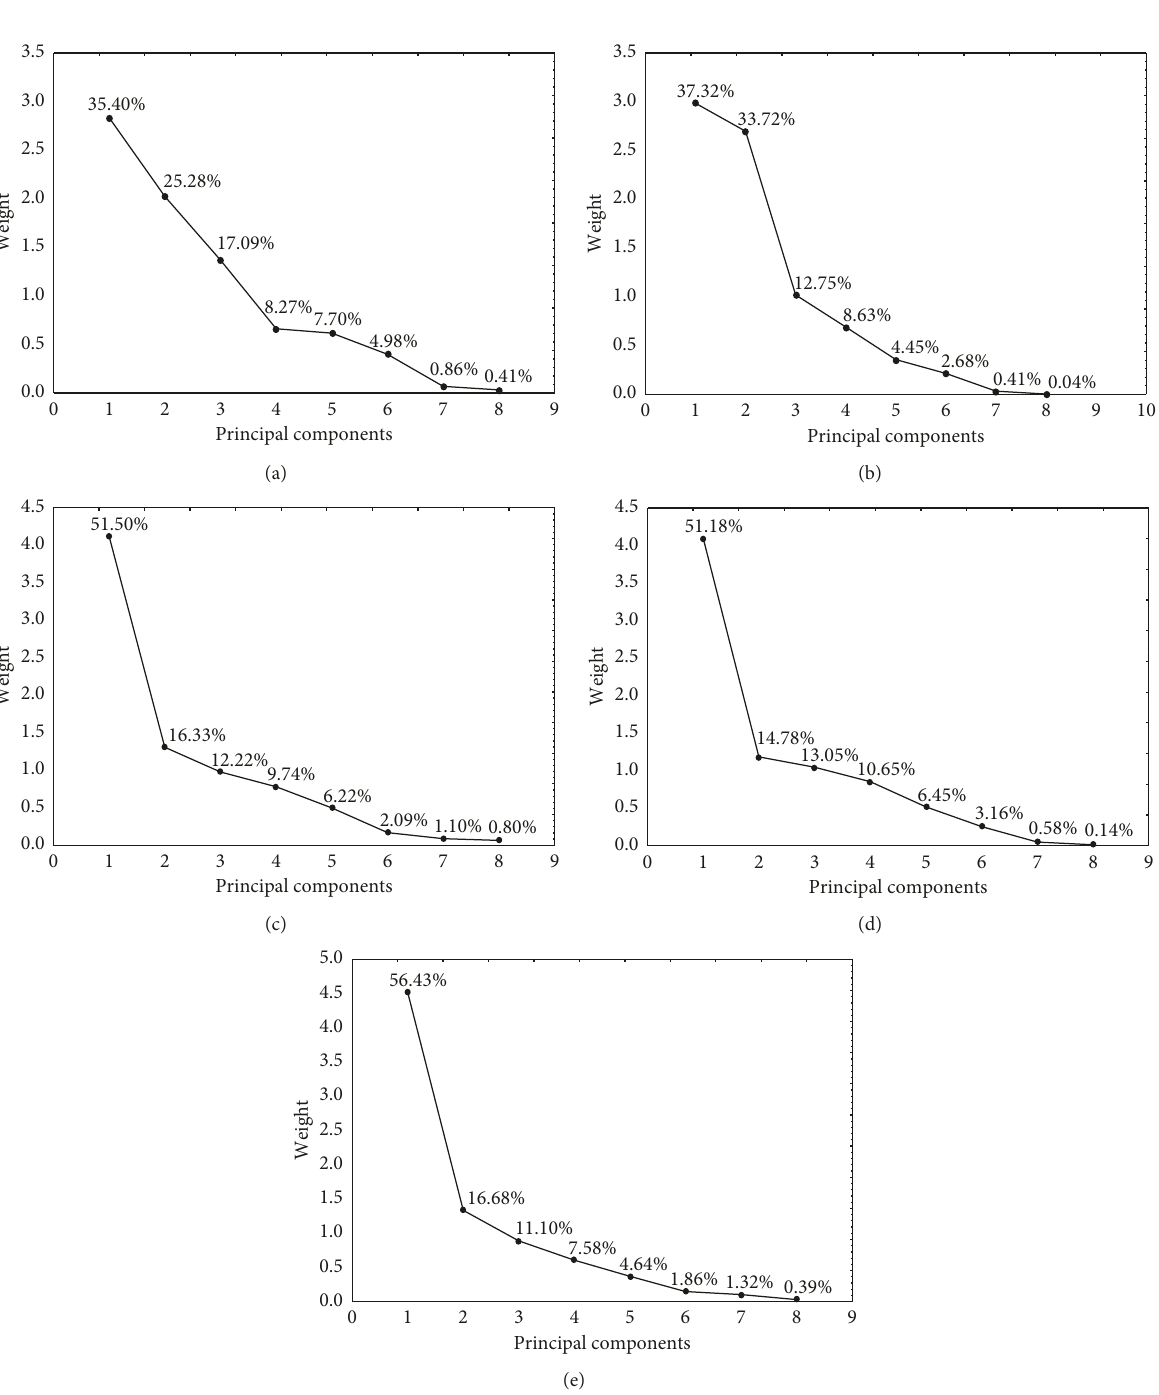
Figure 2: Explained variance of the set of variables for each main component for each collection depth. (a) Extractor depth 0.10m; (b) extractor depth 0.30m; (c) extractor depth 0.50m; (d) extractor depth 0.70m; (e) extractor depth